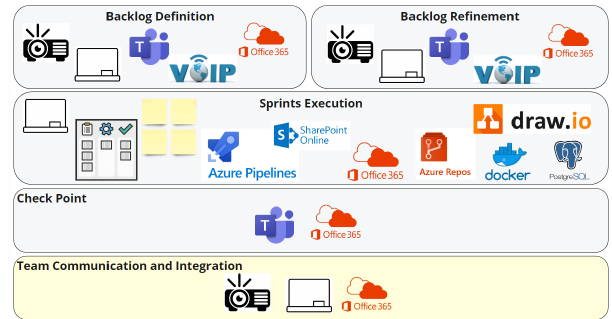
Figure 2. Software process before pandemic – Case